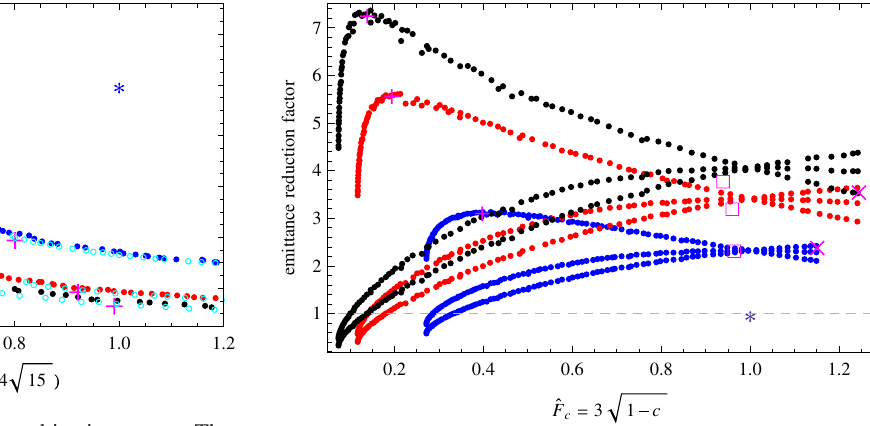
FIG. 2. Emittance reduction factors for AME, TME, and EME lattices based on the optimal solutions (cyan circles) in Fig. 1. Again, the maximum field strength is a factor of 2 (blue), 4 (red), and 6 (black). The pink markers on the curves indicate PGA results and the lattice types of the associated curves as AME ( (cid:2) ), TME ( þ ), and EME ( h ). The differences in EME at high peak fields are due to using 33 instead of 65 or more slices. Note that there are three emittance reduction factors for each dipole profile (a cyan circle in Fig. 1) corresponding to the AME, TME, and EME lattice conditions,